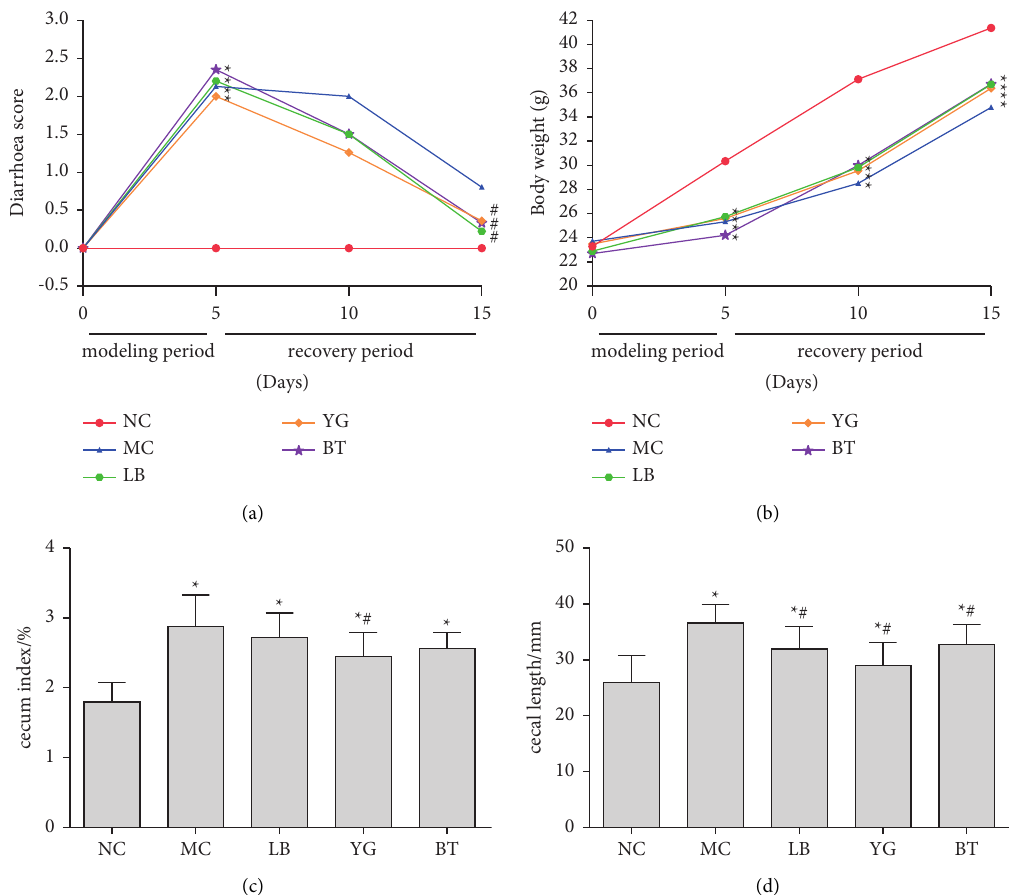
Figure 1: Effect of LB, YG, and BTon diarrhea score (a), body weight (b), cecum index, (c) and cecal length (d) of mice ( n � 8). NC, normal group; MC, model group; LB, Lacidophilin tablet group; YG, yogurt group; BT, bifid triple viable capsule group. Values are represented as the mean ± SD. ∗ p < 0 . 05 compared with the normal group, and # p < 0 . 05 compared with the model